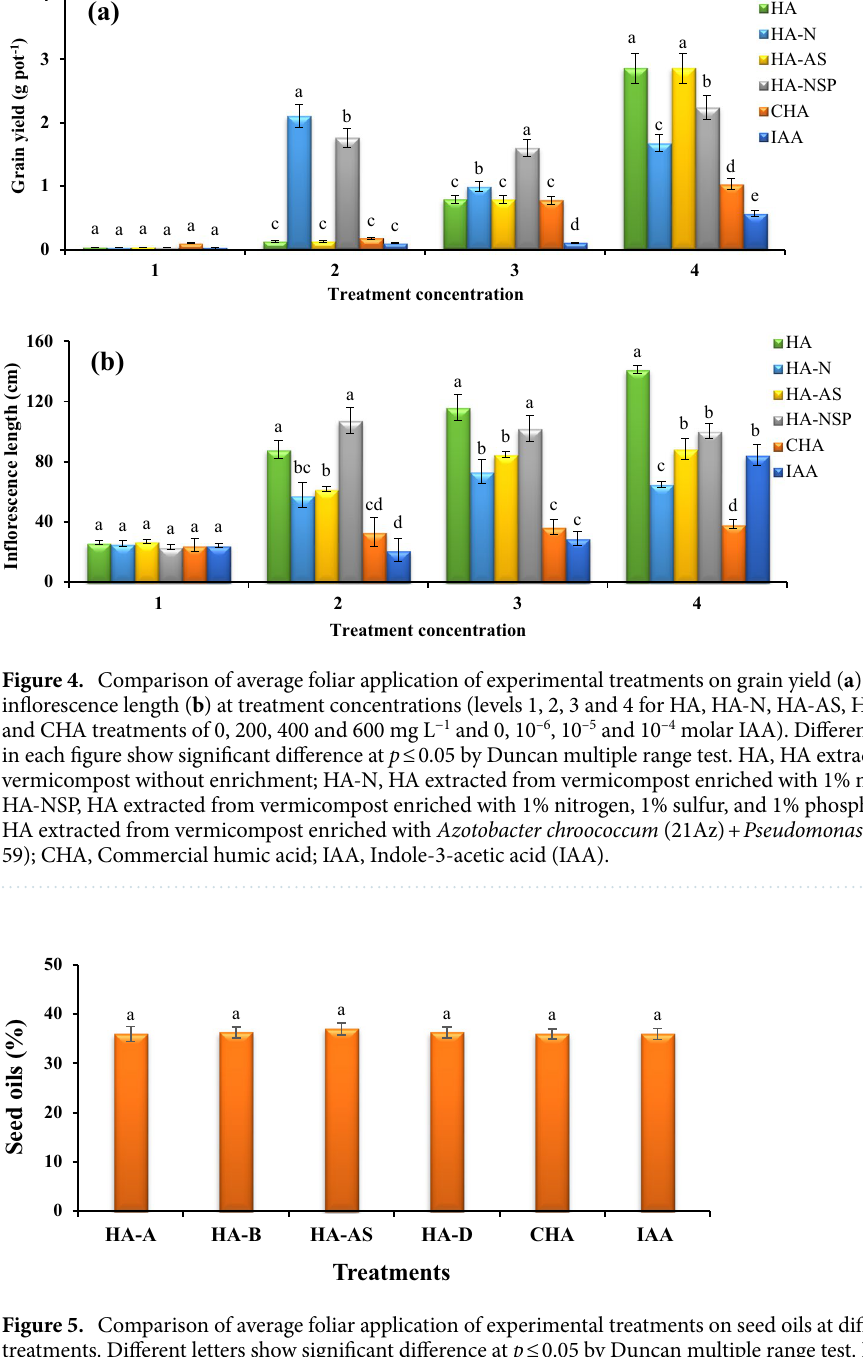
foliar spraying of IAA hormone in improving the price and quality of Brassica juncea leaves at a concentration of 10 –8 M, which was in line with the results of our research. Indole acetic acid as a phytohormone in suitable concentration had positive significant effects on plant growth 37,38 . It has been reported that IAA improves vegeta- tive growth in plants by increasing cell division, photosynthesis and chlorophyll accumulation, and its positive effects on plants such as rice and maize have been determined by increasing leaf area and number, leaf diameter and plant height 39,40 . Canola plant height and stem diameter in our experiment were affected by HA extracted